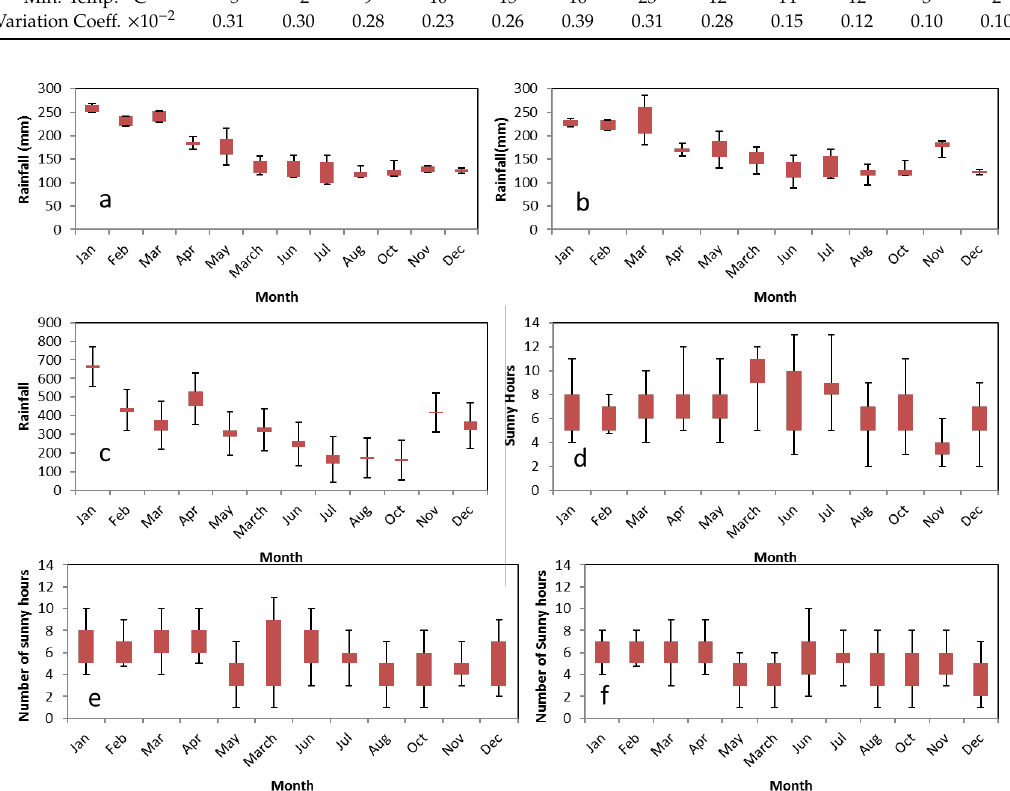
Figure 3. ( a ) Monthly temperature for the 2008 – 2018 in EAZP, ( b ) monthly temperature for the 2008